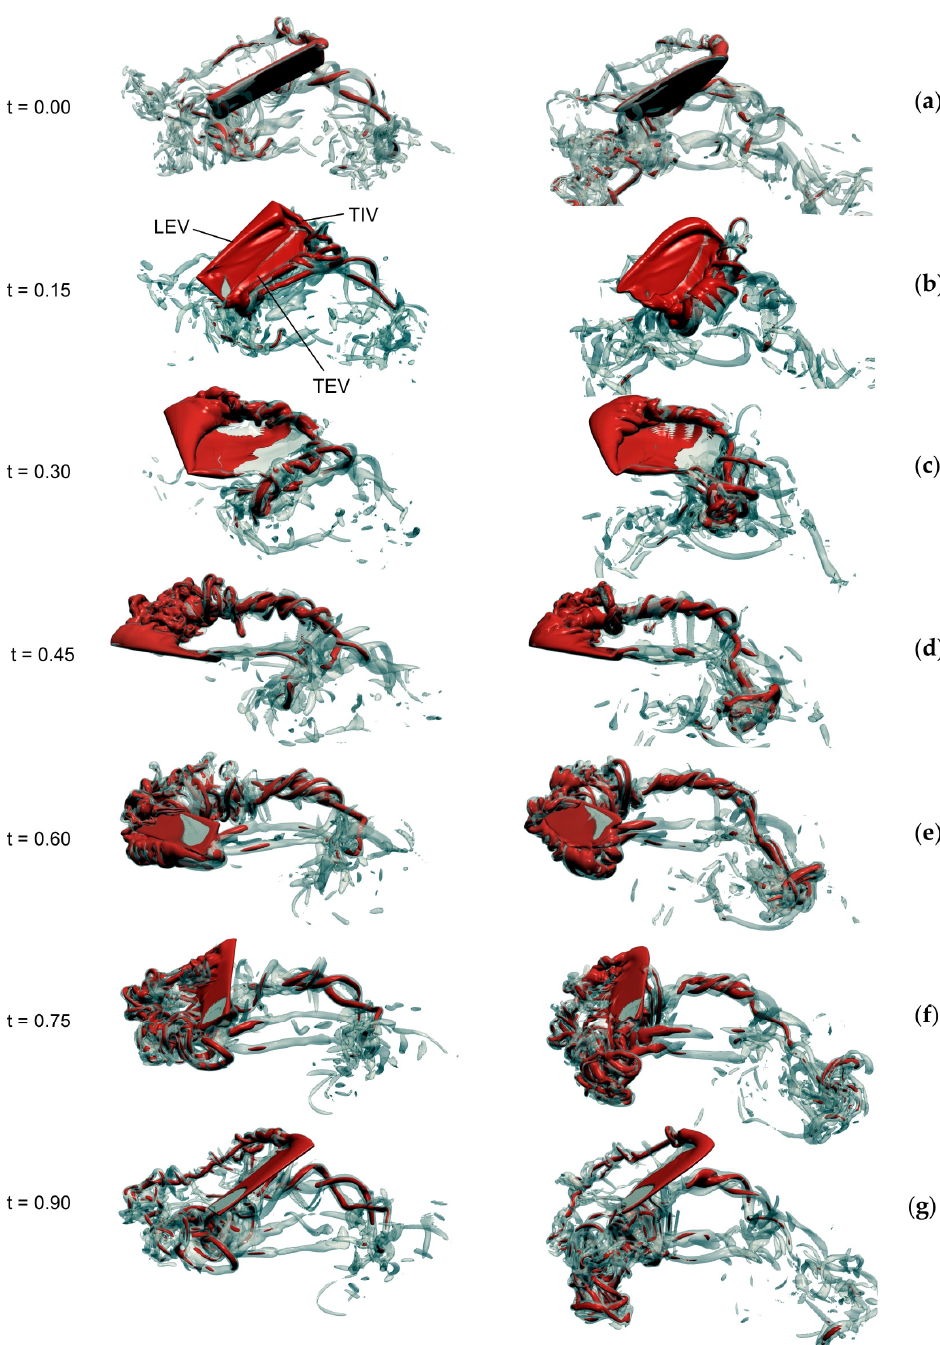
Figure 4. Evolution of vorticity in a flapping rectangular (left) and blowfly (right) wing. ( a – g ) Vorticity distribution at the beginning of the 3rd flapping cycle (t = 0–1) after motion onset. Vorticity of a flapping wing of Calliphora vomitoria slightly differs from the flow in the rectangular wing. Data show iso-surface with vorticity magnitude of 75 s − 1 (semi-transparent grey) superimposed on a vorticity iso-surface with 150 s − 1 (red). LEV, leading edge vortex; TEV, trailing edge vortex; TIV, wing tip vortex. For performance data and wing kinematics confer to table 1 and a previously published study [83] , respectively. Wing length and area are identical in both wings.